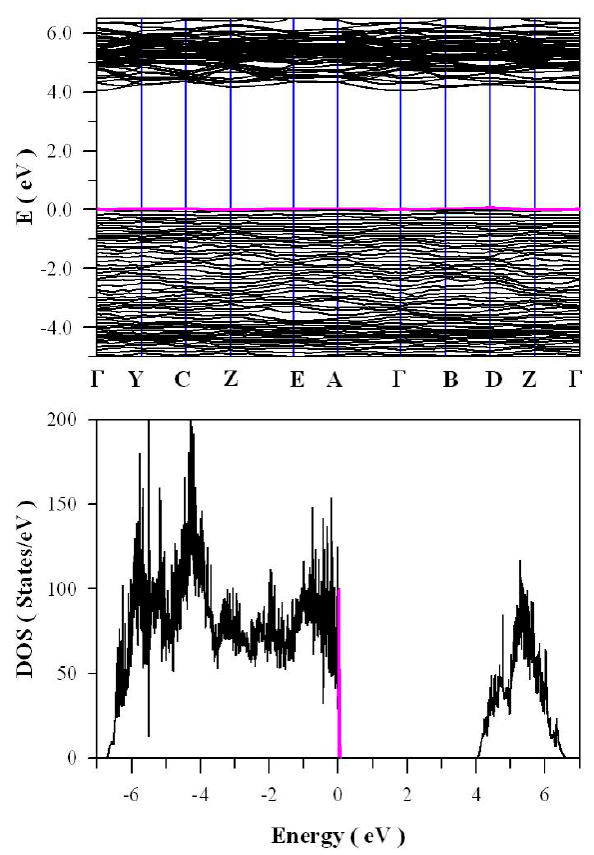
Figure 14. DFT calculated electronic structures for zinc deficient ZnWO 4 (Zn 1 − δ WO 4 where δ = 0.0625): ( a ) band structure; and ( b ) density of states.